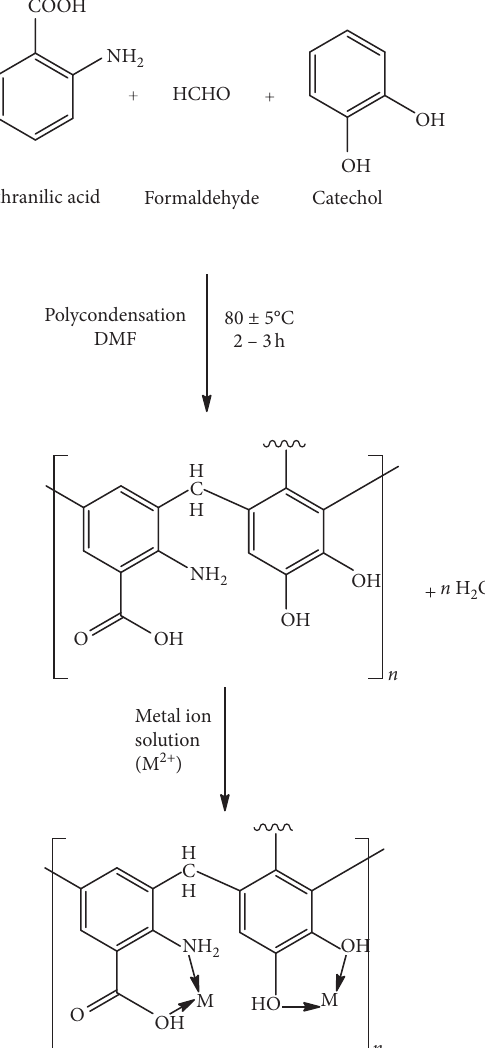
Figure 1: Reaction scheme of the ACF